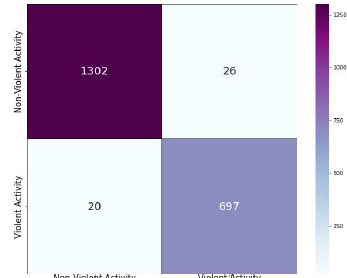
Fig. 10. Confusion